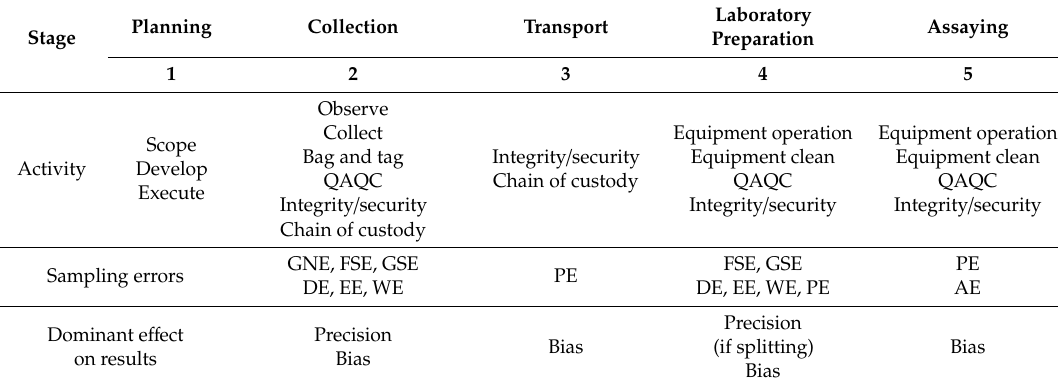
Table 1. Sampling value chain from programme planning to